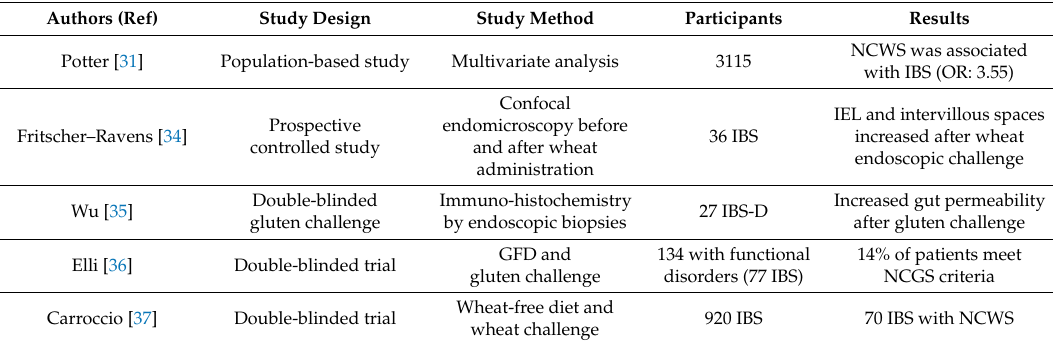
Table 1. Summary of the most significant studies on IBS related to gluten / wheat and NCGS / NCWS.